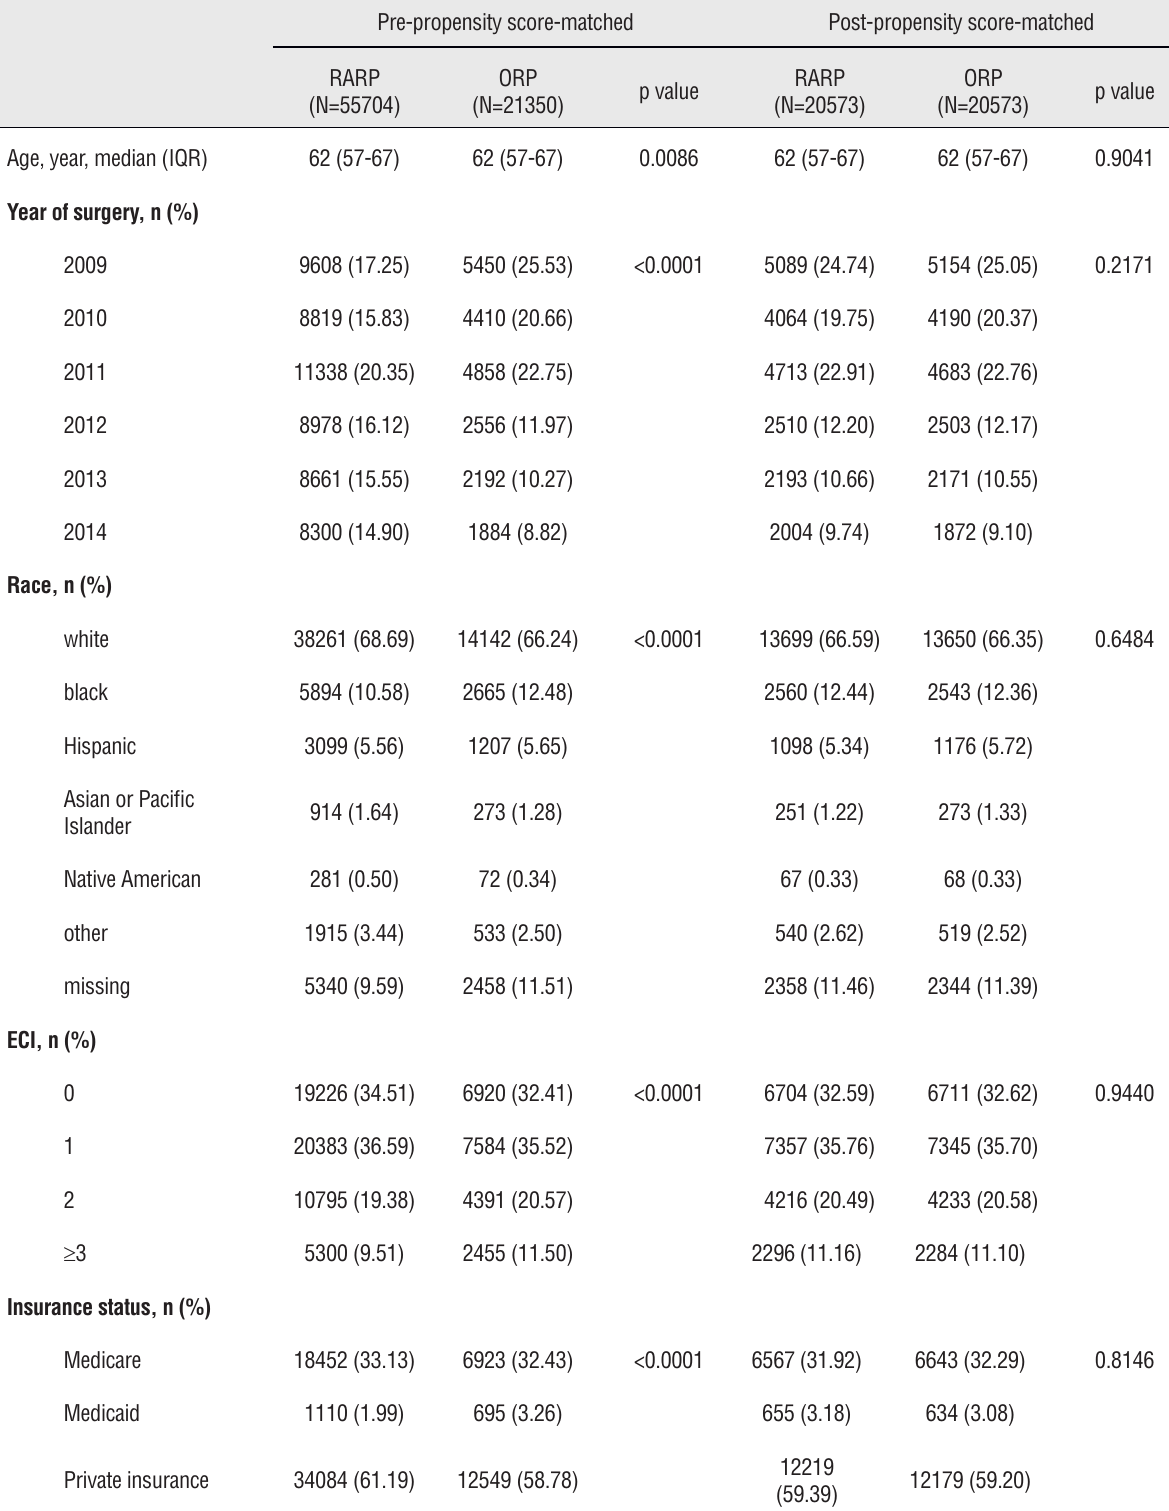
Table 1 - Demographic characteristics of patients treated with radical prostatectomy for prostate cancer. Pre-propensity score-matched Post-propensity